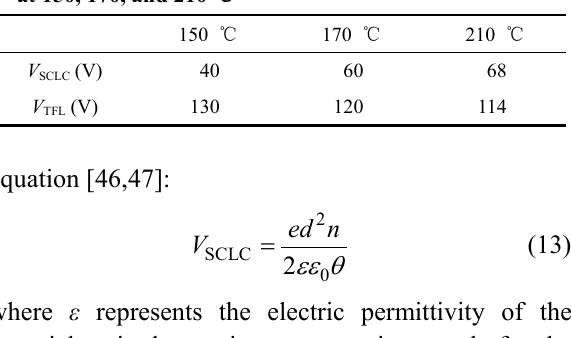
Fig. 11 (a) W m of NBT ceramics at 1 kHz and (b) R min of NBT ceramics at 1 kHz. Table 2 V SCLC and V TFL values of the NBT